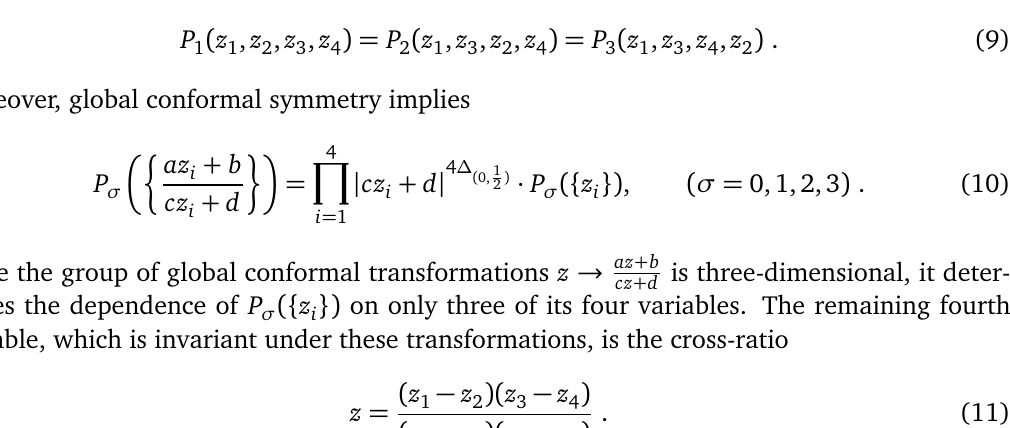
Table 1: Values of q , c , and ∆ ( (1) between c and q are lifted by assuming 1 z , z , z , z are [ 10 1 2 3 4